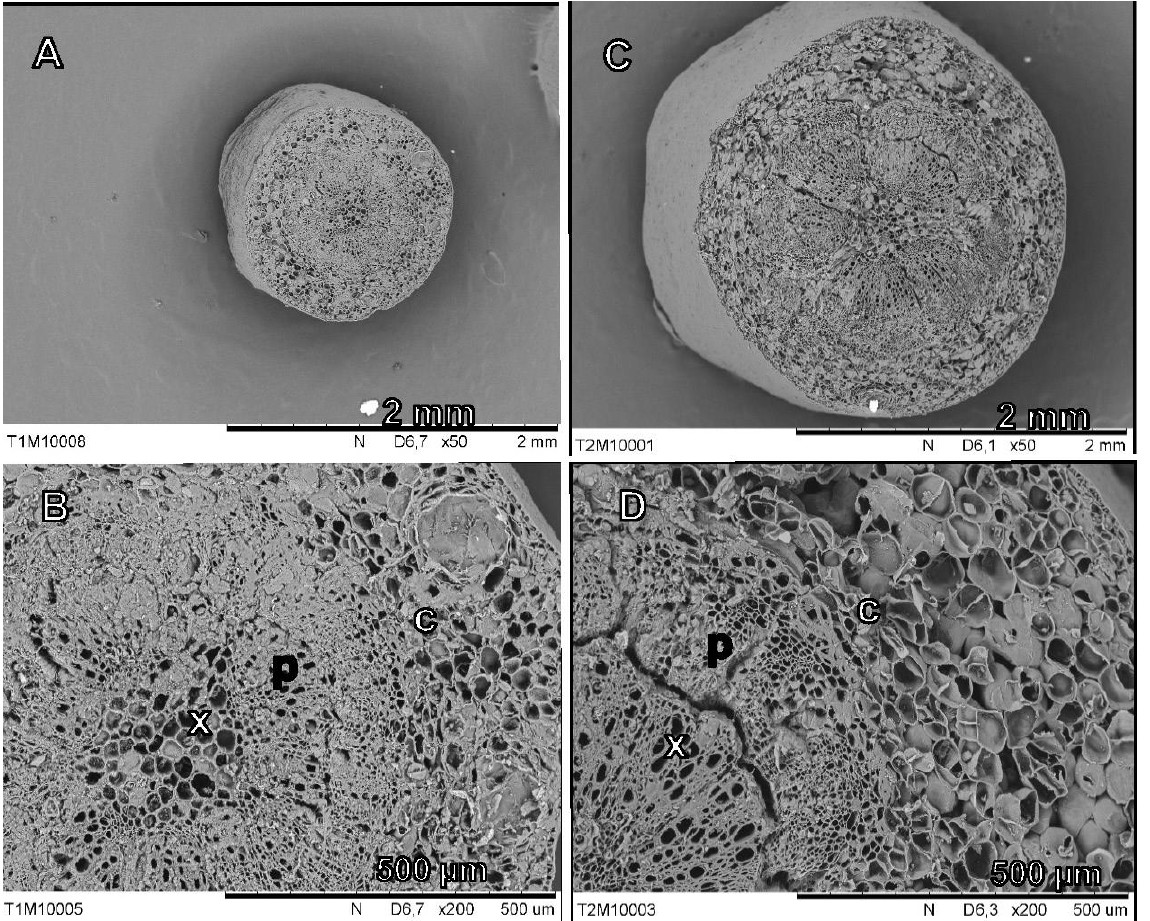
Figure 7. Pedicel cross-section (x50) of 30 DAFB ( A , B ) and 44 DAFB ( C , D ) orange fruits observed by SEM. Entire cross-sections ( A , C ) and magnified images (x200) ( B , D ) showing the xylem (x), phloem (p), and cortex (c).